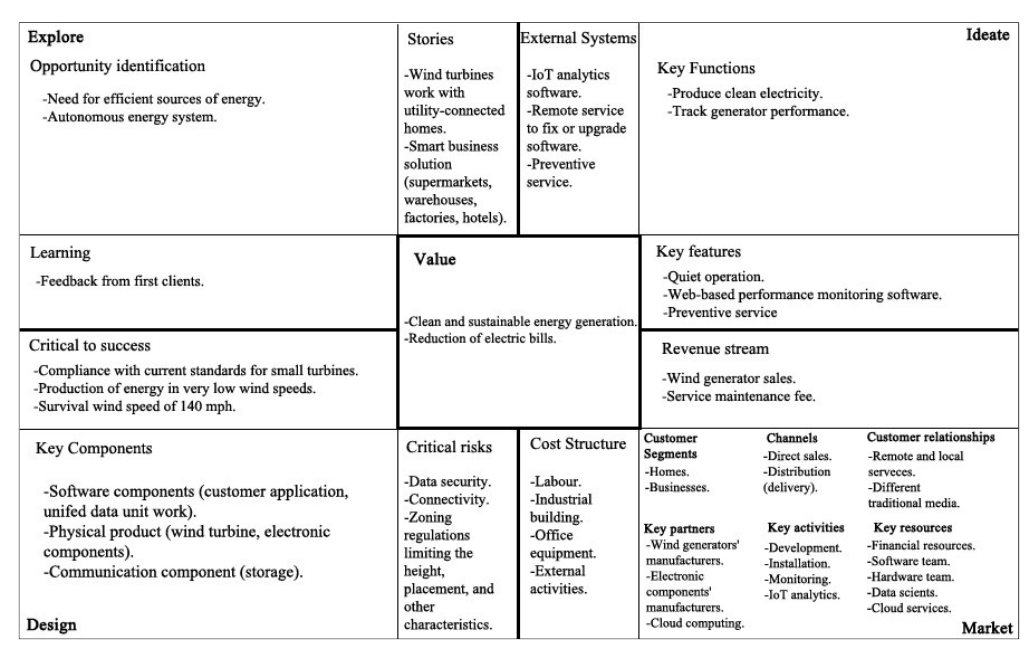
Fig. 1. Business Model for Smart Wind Generator based on the Innovation